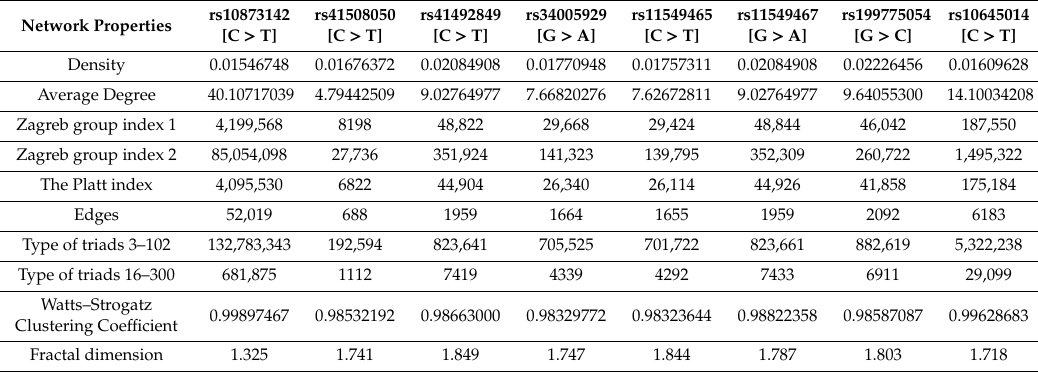
In Table 4, the statistical properties of graphs Γ ( ϕ i , j ) of sequence ( ϕ i , j ) from non-cancer DNA